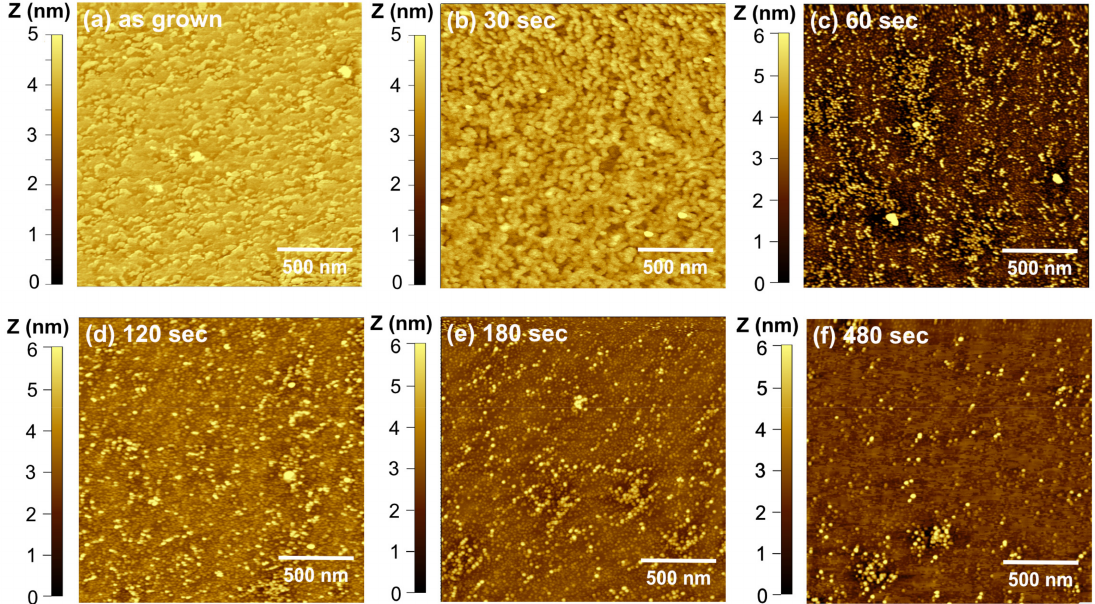
Figure 4. Atomic force microscope images showing the progress of InGaN QD formation using PEC etching with a coherent light source at 0.9 V. The images are for the ( a ) as-grown surface and etched for ( b ) 30 s, ( c ) 60 s, ( d ) 120 s, ( e ) 180 s, and ( f ) 480 s. The QDs form at 60 s and have heights that vary from 2 to 5 nm. As the etching time increases, the QD density decreases from ~7 × 10 10 /cm 2 at 60 s to ~1.5 × 10 10 /cm 2 at 480 s.